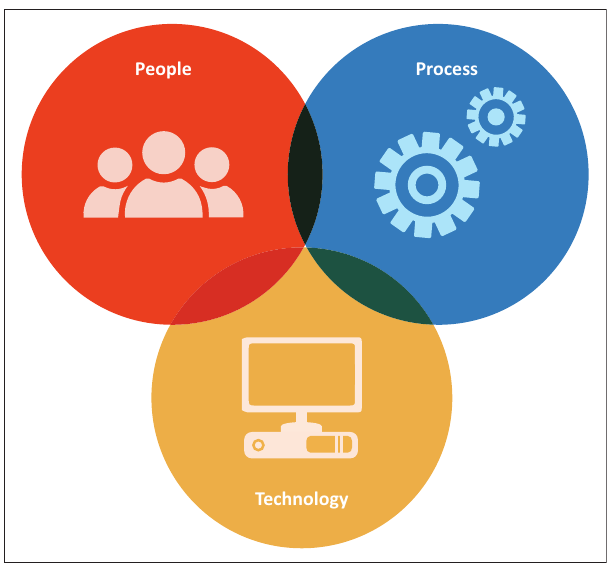
FIGURE 1: Aligning people, process and technology in knowledge